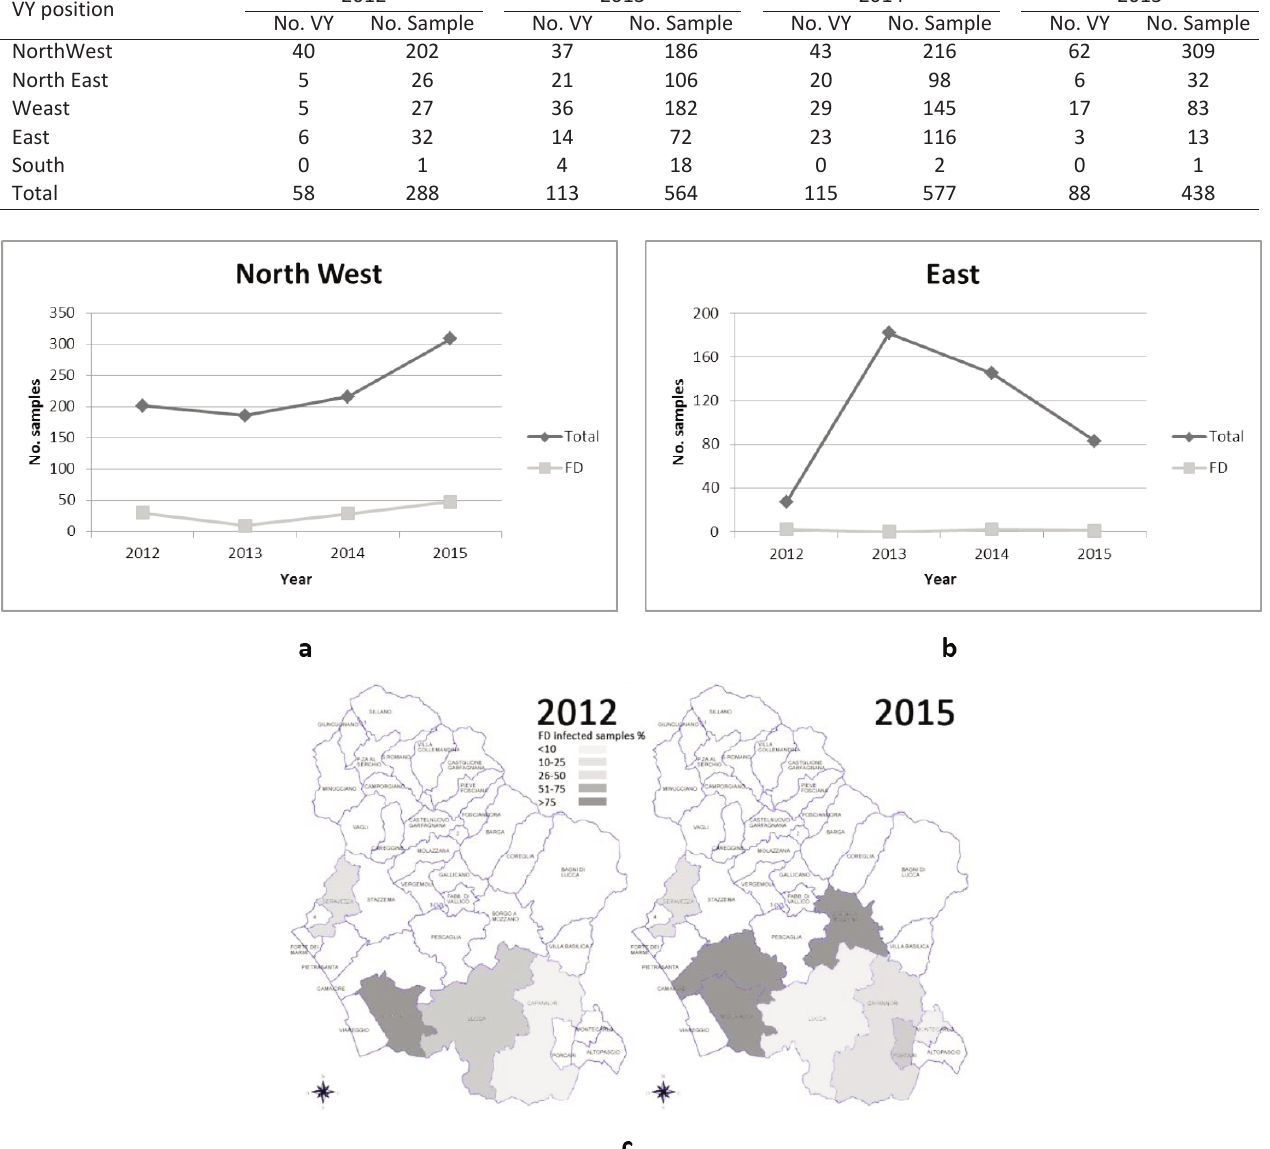
Fig. 2 - Number of samples positive to “flavescence dorée” (FD) out of total samples tested in 2012-2015 in (a) North West and (b) East areas of Tuscany; (c) comparison of incidence of FD in Lucca district in North Western Tuscany in 2012 and